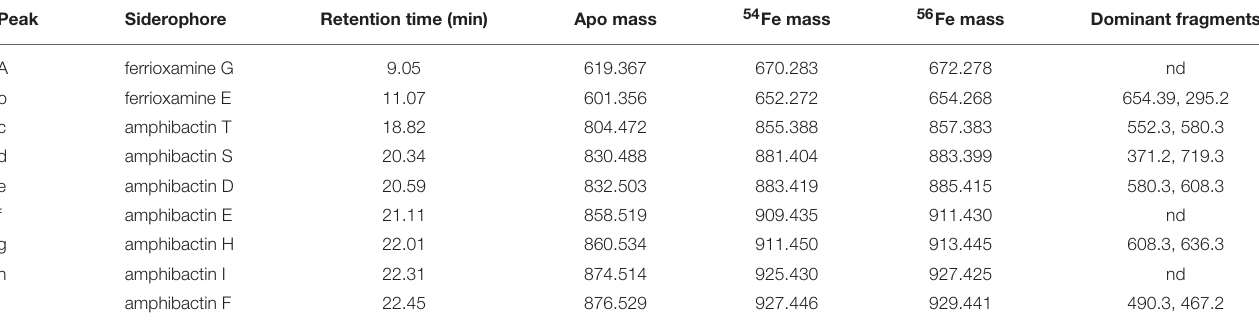
TABLE 2 | Siderophore peak identities in each sample as presented in Figure 2 , with the siderophore name, retention time (min), apo mass (iron free), 54 Fe and 56 Fe mass, and the dominant fragments from the MS 2 fragmentation spectra. Peak Siderophore Retention time (min) Apo mass 54 Fe mass 56 Fe mass Dominant